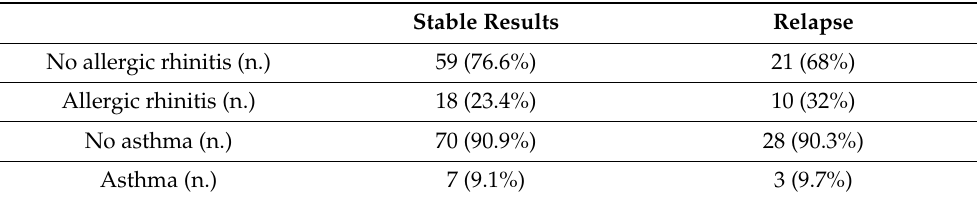
Table 2. The number of stable cases and relapses in the allergic, no allergic rhinitis, asthma, and no asthma groups ( p =